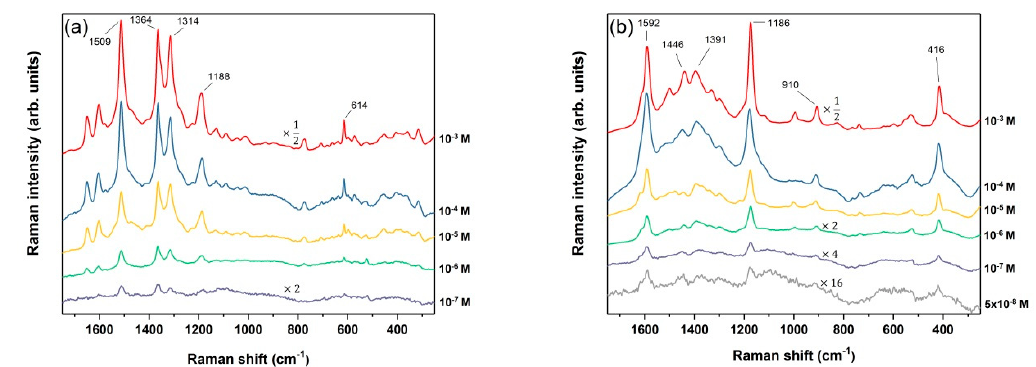
Figure 9. The SERS spectra of ( a ) R6G and ( b ) CV (both 100 scans, 500 mW), deposited on RF S2 samples at different dilutions (higher to lower concentrations from top to bottom). Spectra are offset along the y -axis for clarity.